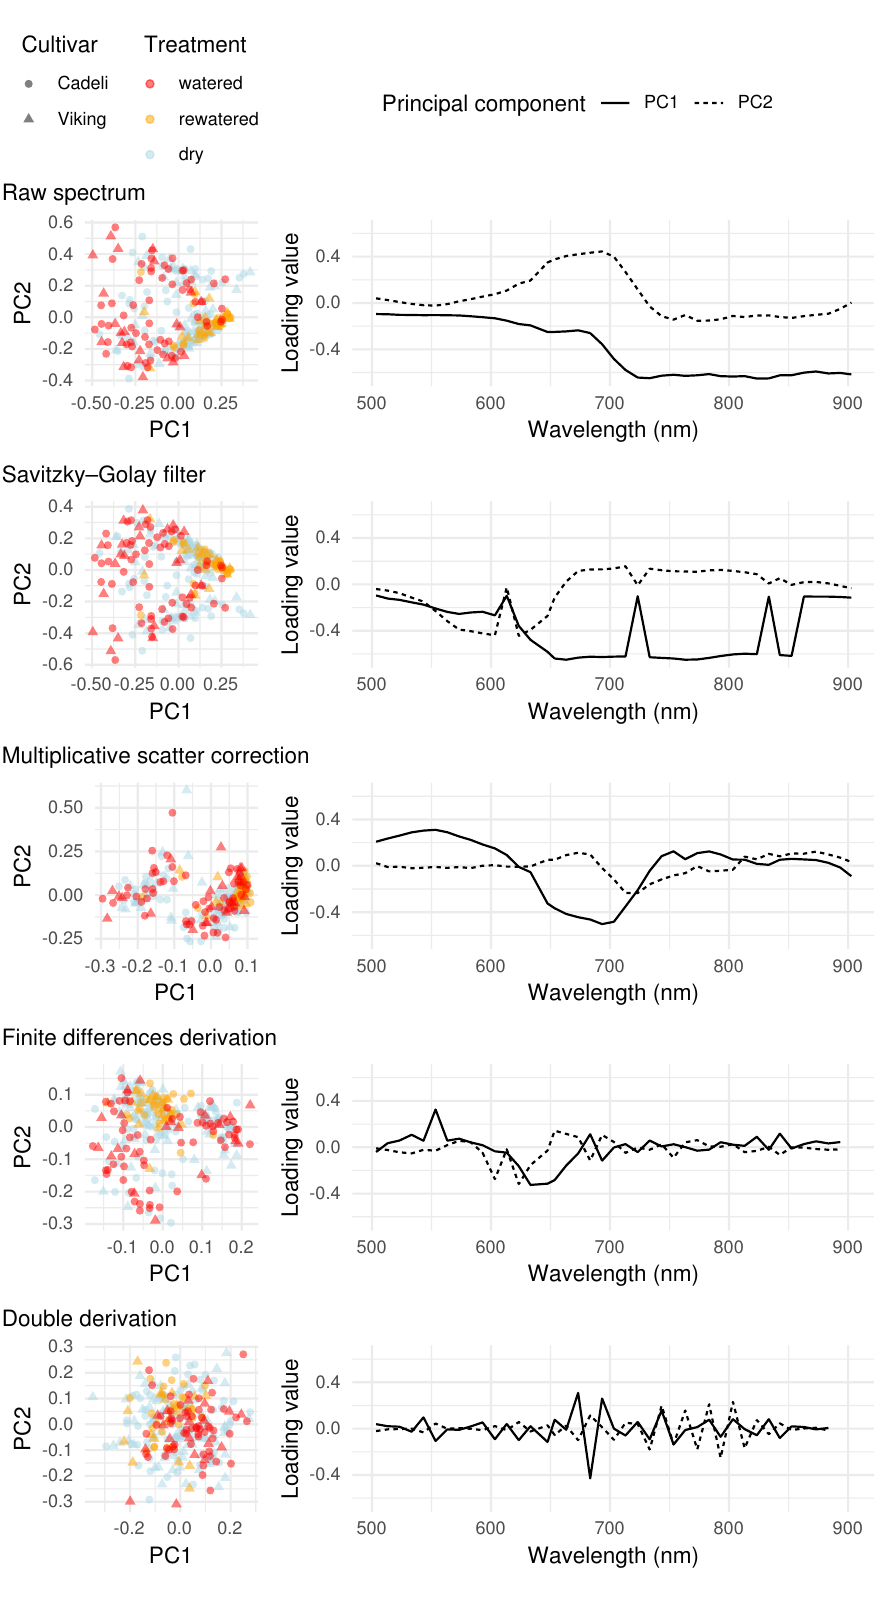
Figure 7. Principal component scores (left-hand column) and loadings (right-hand column) of the pixel reflectance values according to image pretreatment. Colour and shape differentiate observations with respect to the experimental